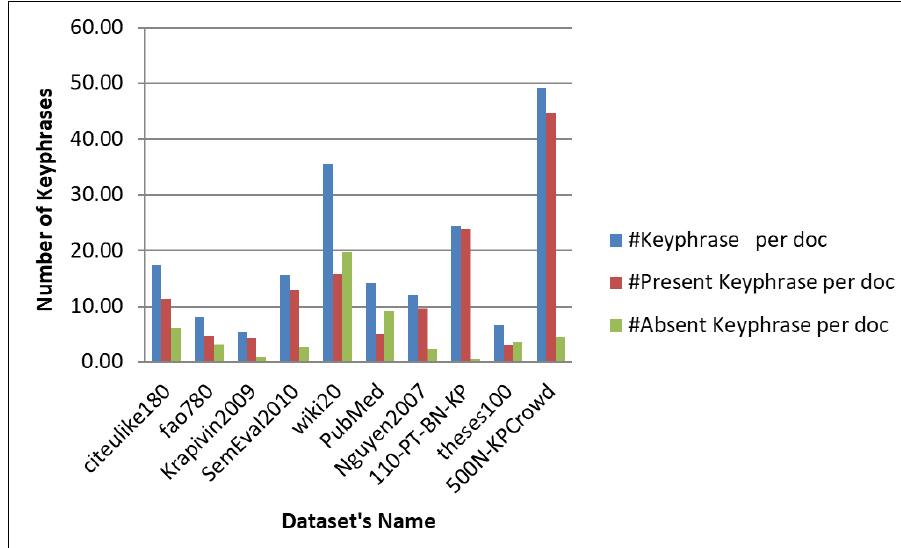
Figure 3. Analyze the present and absent keyphrases per doc for every dataset.